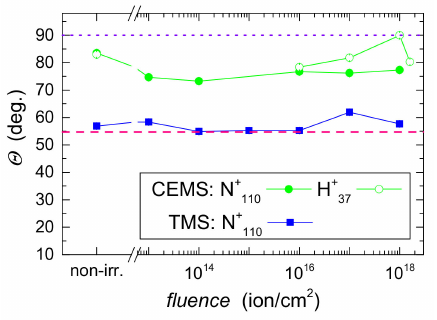
Figure 9. Orientations of net magnetic moments characterized by the angle Θ of the ted against the ion fluence. Pink dashed and violet dotted lines represent Θ -values that correspond to random and in-plane orientations of spins, respectively. Solid lines are only guides to an